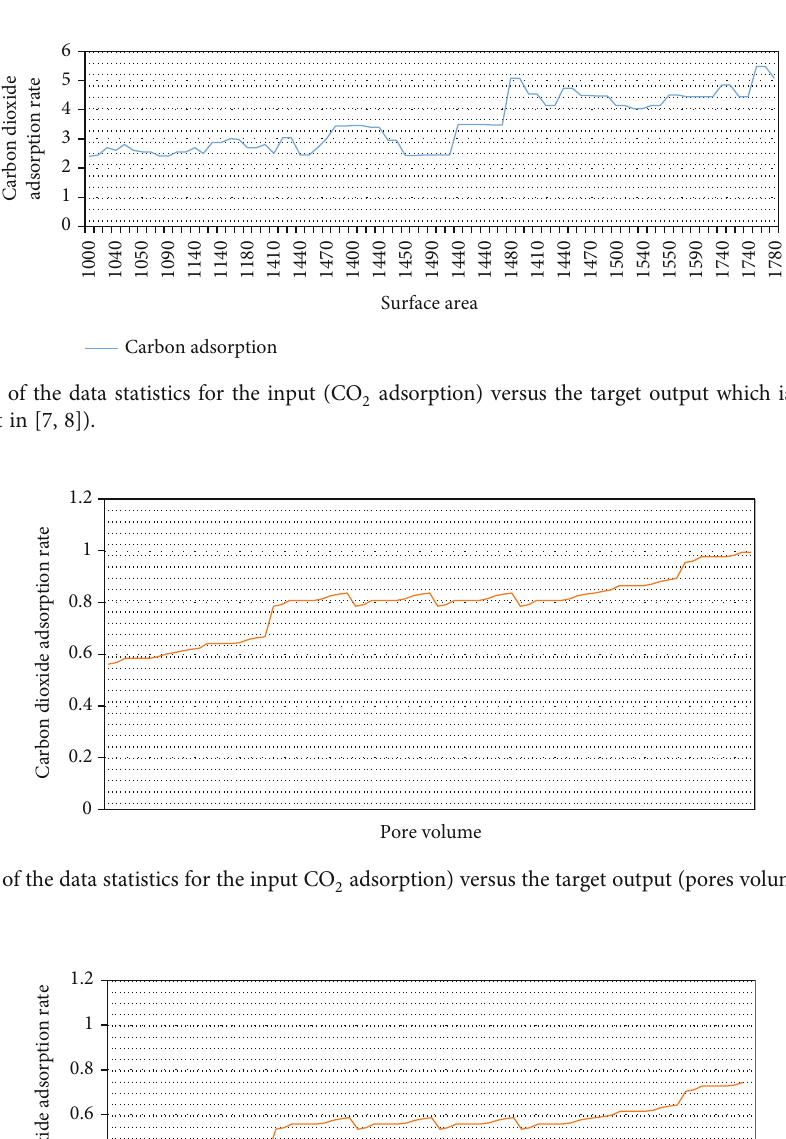
adsorption) versus the target output (macro pores volume) (data is 2